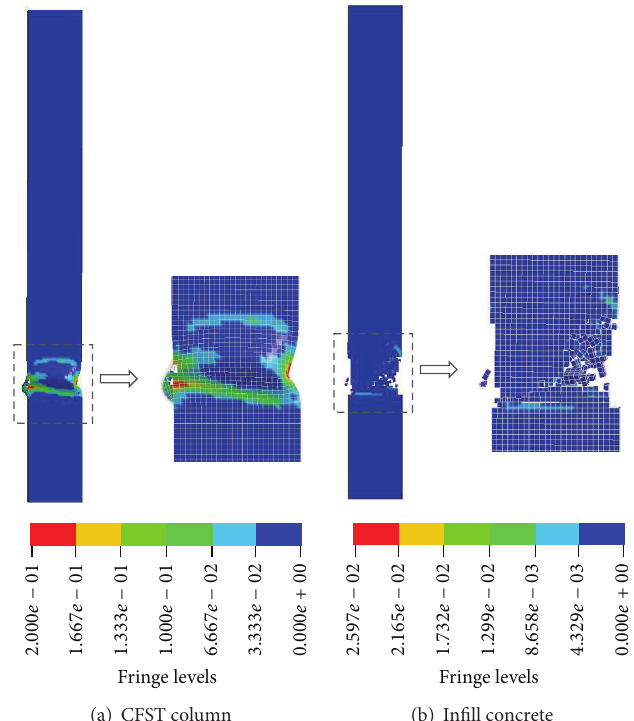
Figure 9: Localized damage mode of CFST column under blast